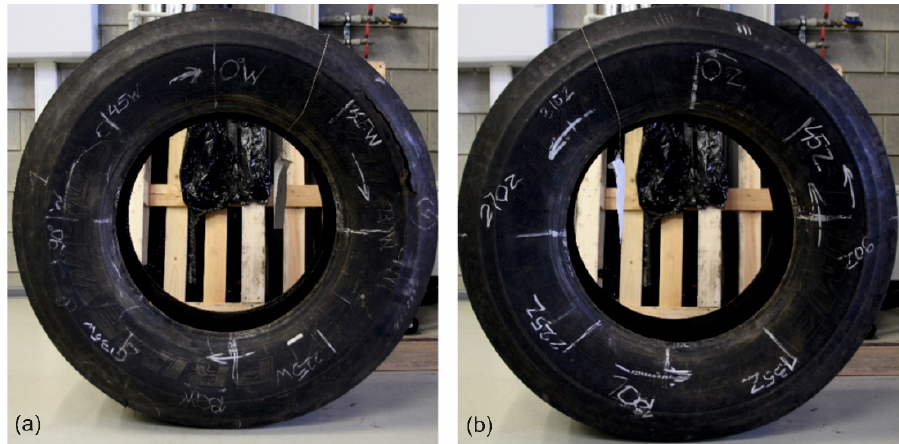
Figure 4. Tire markings applied during the tests: ( a ) inner side of the tire; ( b ) outer side. Upon visual inspection of the tire sidewall from the “inside” side, the following